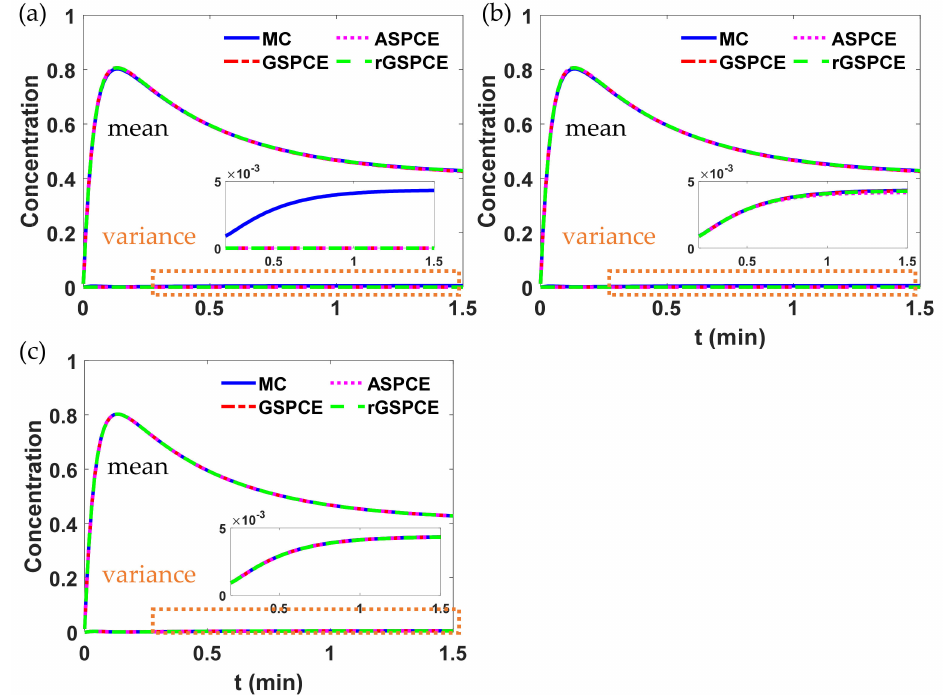
Figure 8. Simulation results of concentration C B with different polynomial orders ( P ) in each case study: ( a ) P = 0, ( b ) P = 1, and ( c ) P =